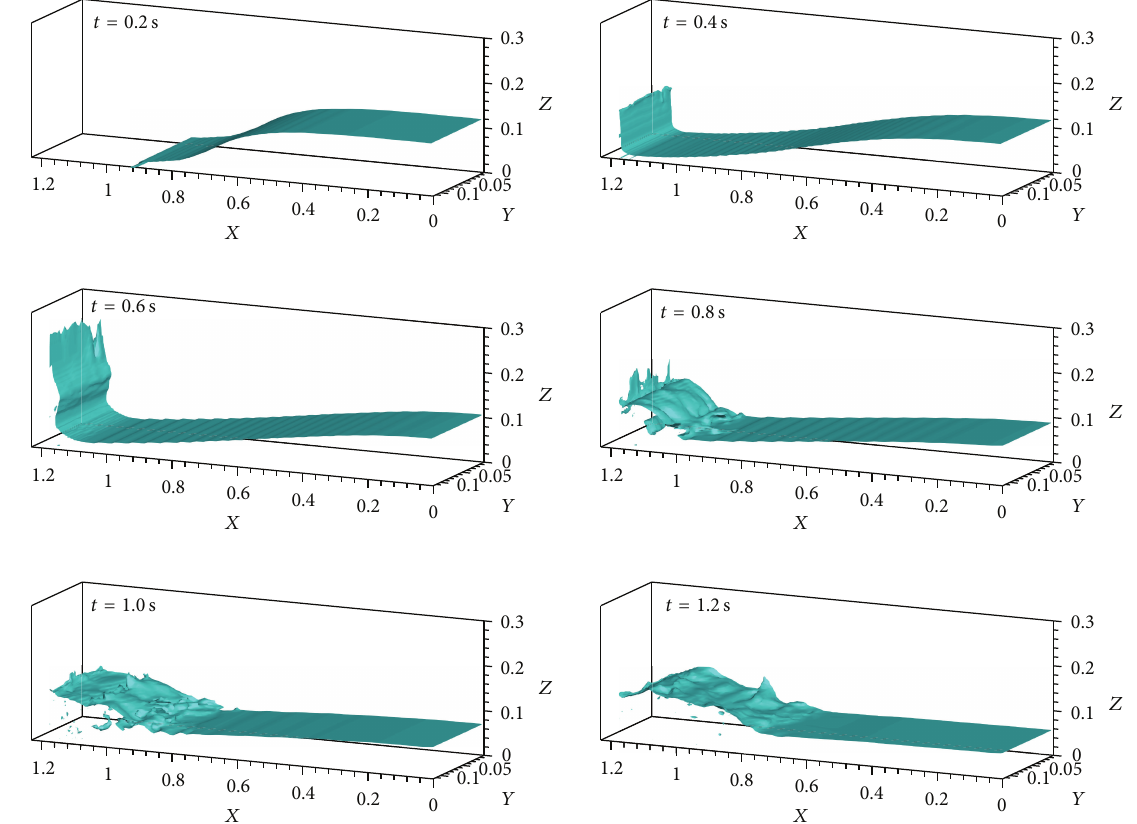
Figure 7: Evolution of the 3D water collapse and interaction with the opposite wall.